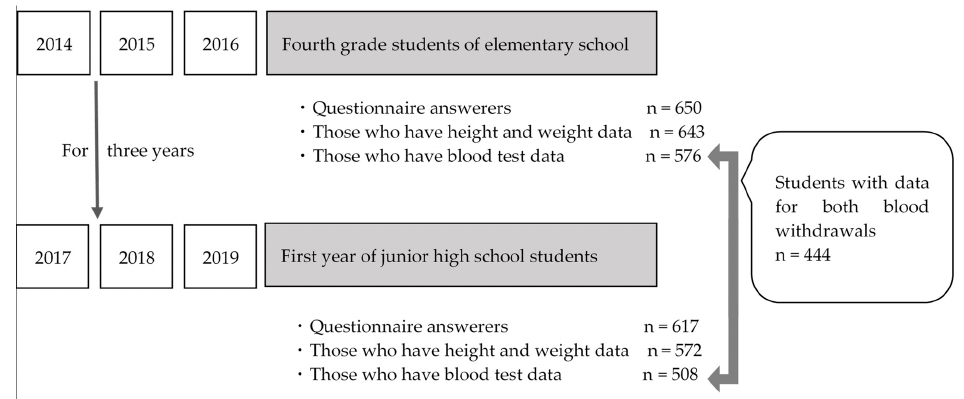
Figure 1. A flowchart presenting the recruitment procedure.